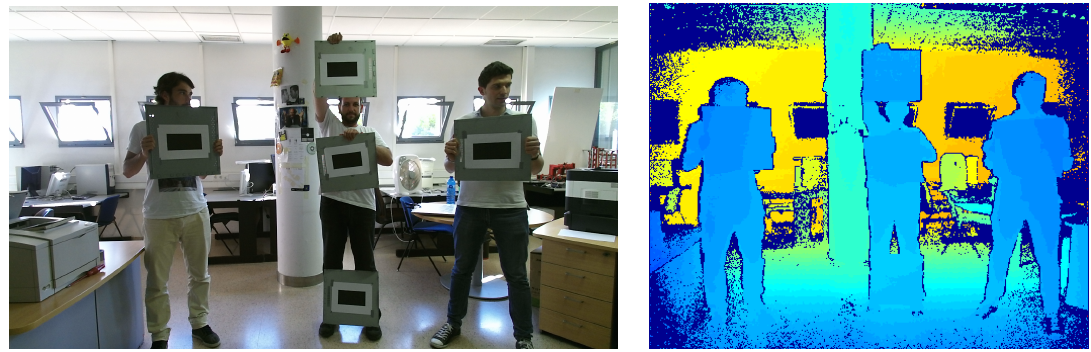
Figure 14. Color ( left ) and depth ( right ) images of the markers distributed in the